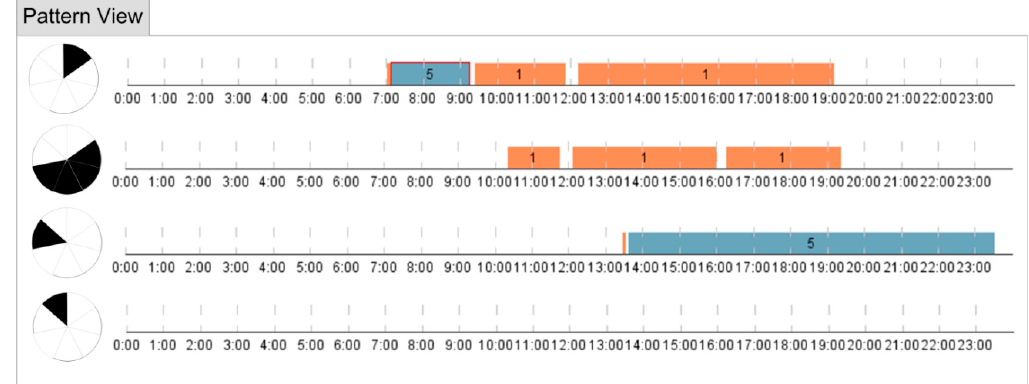
Figure 18. The typical routes of the IT employee from the cluster.